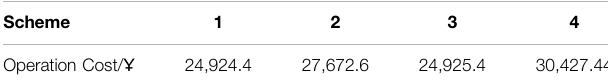
TABLE 2 | Operation cost under different con fi guration